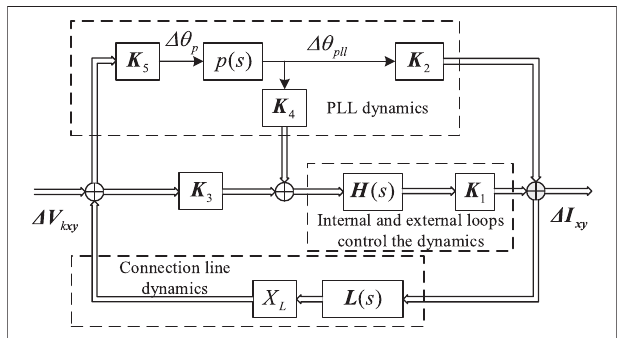
FIGURE 2 | Diagram showing dynamic process of GSC of k th PMSG considering PLL.